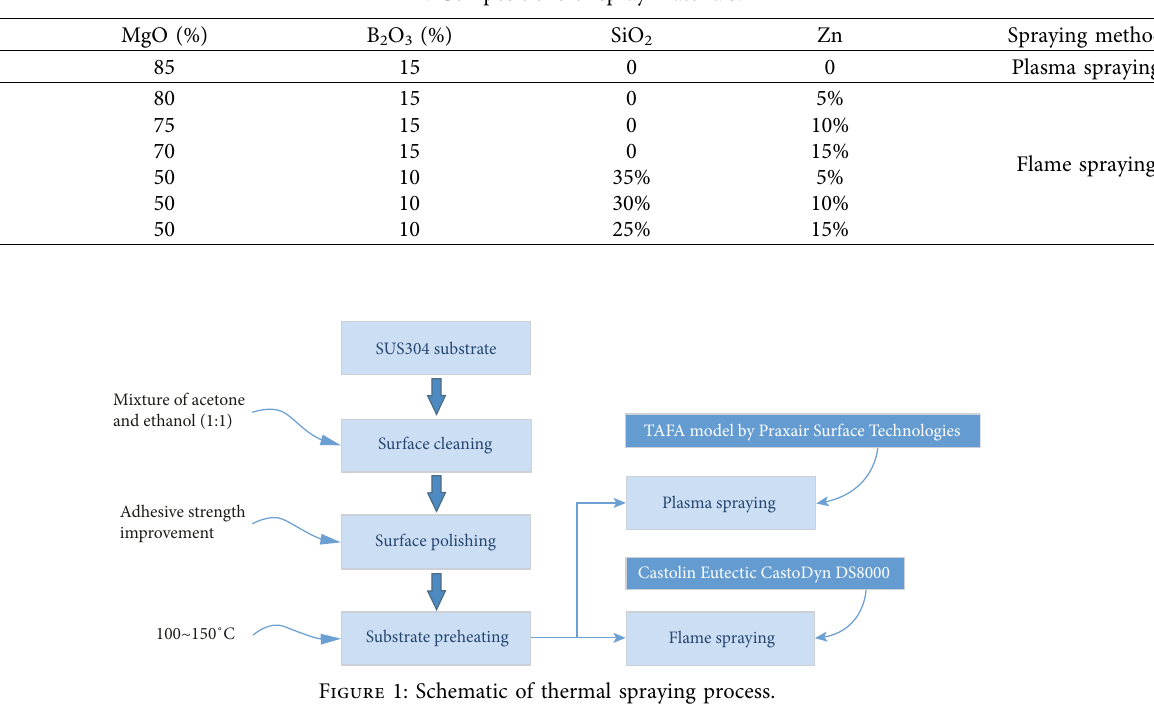
Table 2: Compositions of spray materials.